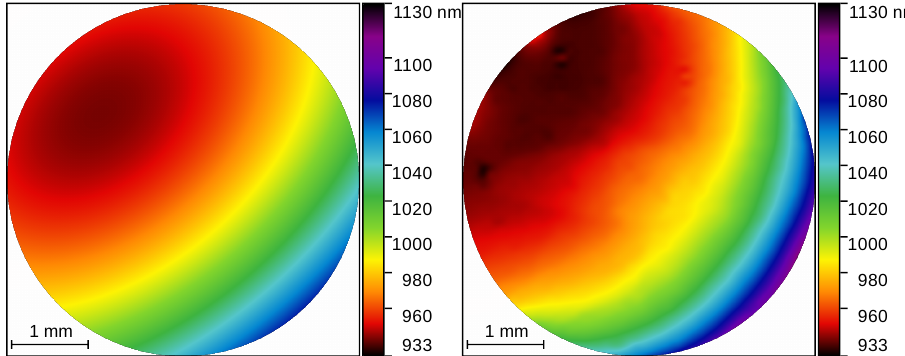
Figure 6. The profiles of local thicknesses of the SiO x C y H z film. The solid lines correspond to result obtained by the ellipsometric method, the dashed lines correspond to results obtained by imagining spectroscopic reflectometry (ISR).